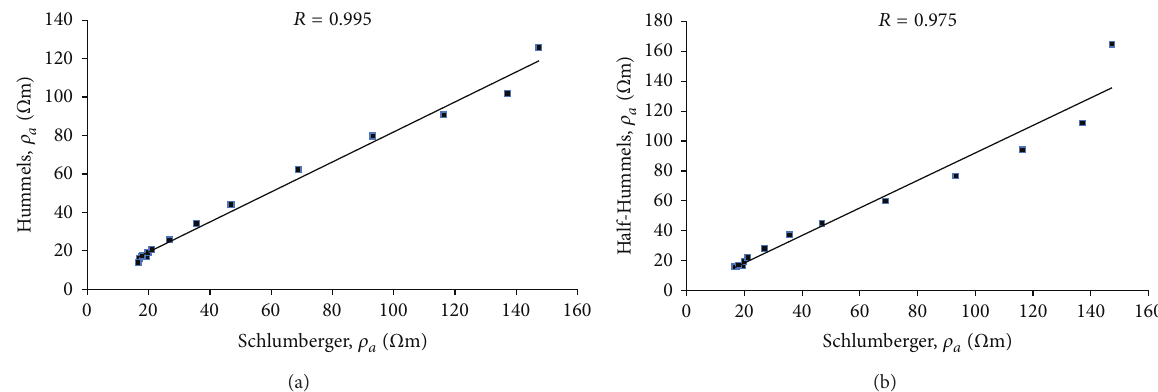
Figure 28: Statistical plot of apparent resistivity data for location 19 (amphibolite) (a) Hummel against conventional Schlumberger (VES) and (b) “Half-Hummel” against conventional Schlumberger